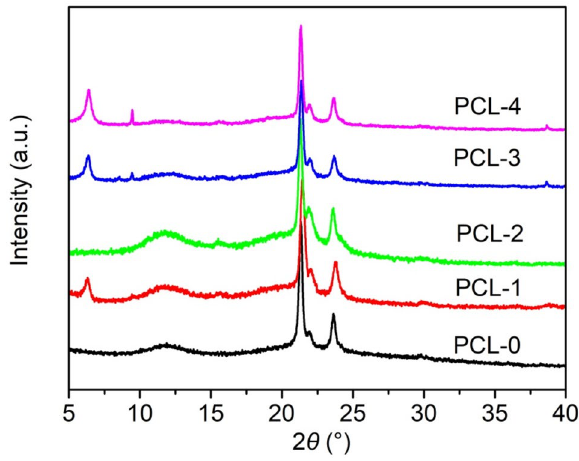
Figure 6. XRD patterns of PCL-based nanofibrous membranes.